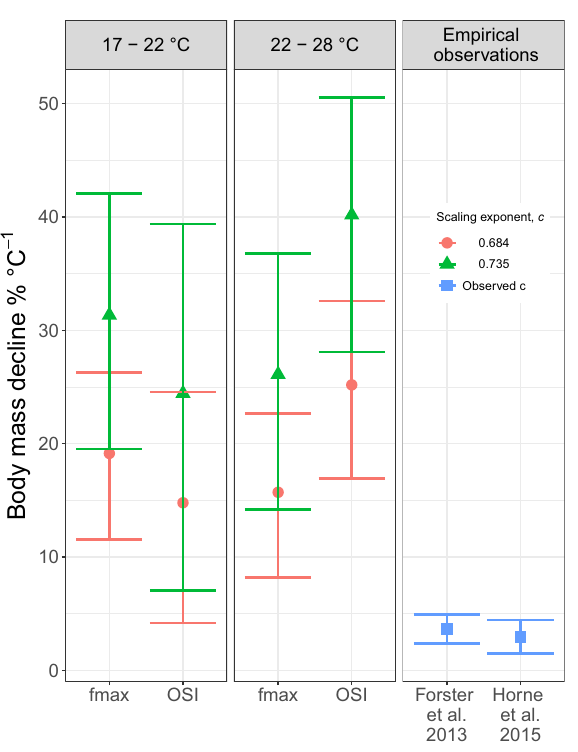
Figure 1. Predicted and observed declines in body mass of aquatic ectotherms with increasing temperature (temperature-size rule slopes, error bars ± 95% CI). “ fmax ” gives the predicted slopes based on empirical measurements of fmax , and “ OSI ” those based on the oxygen supply index. Slopes were estimated for two temperature intervals, and for the two boundary values of the surface area-body mass scaling exponent c (red circles c = 0.684, green triangles c = 0.735). Values (mean ± 1.96 SE) from two meta-analyses of aquatic ectotherms are given for